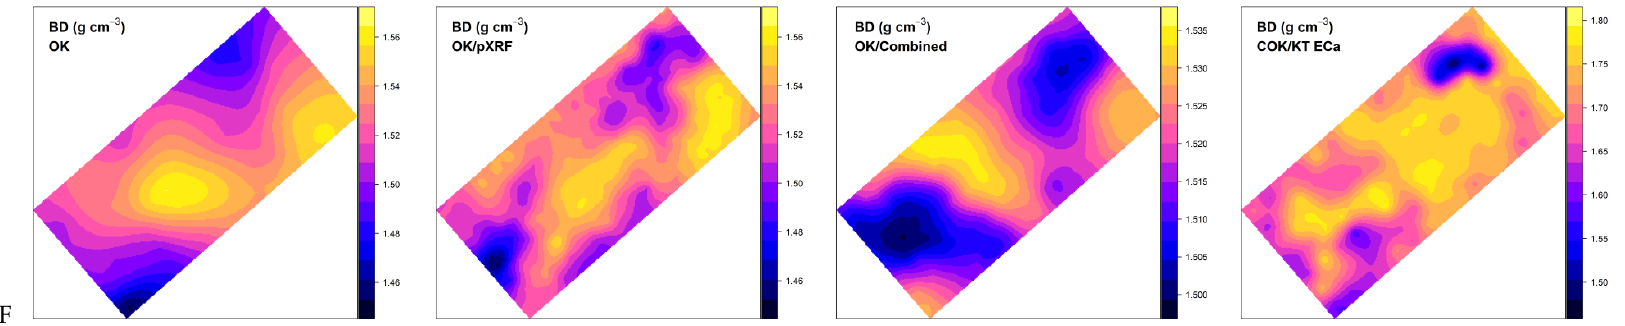
Figure 4. Maps of soil ( A ) organic carbon content (OC; g kg − 1 ), ( B ) sum of bases (SB; cmol c kg − 1 ), ( C ) cation exchange capacity (CEC; cmol c kg − 1 ), ( D ) clay content (g kg − 1 ), ( E ) volumetric moisture ( θ ; %), and ( F ) bulk density (BD; g cm − 3 ). OK, ordinary kriging; COK, ordinary cokriging; eTh, equivalent Th content; ECa, apparent electrical conductivity; pXRF, DP-6000 portable X-ray fluorescence spectrometer; RS, RS-230 BGO gamma-ray spectrometer; KT, KT-10 S/c MSa/ECa sensor.